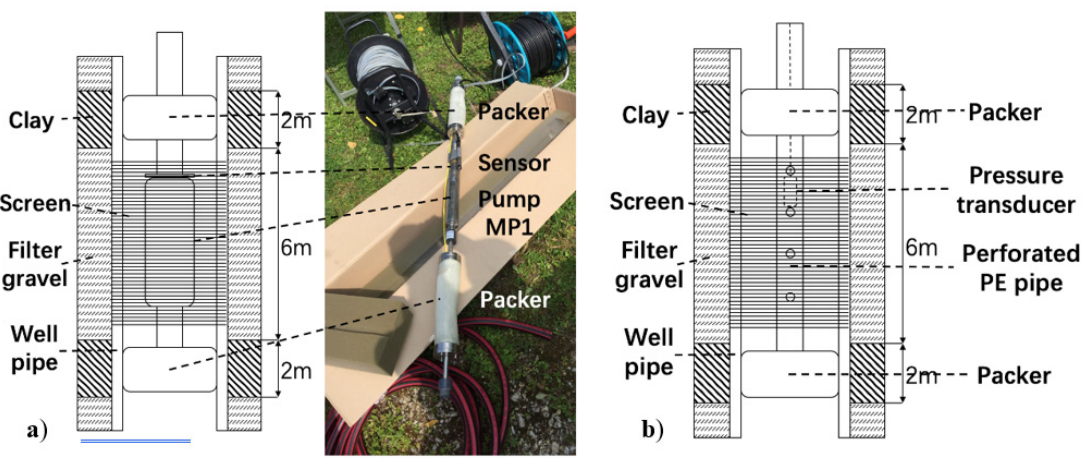
Figure 5. Double packer systems ( a ) within the pumping well and ( b ) within the observation well.